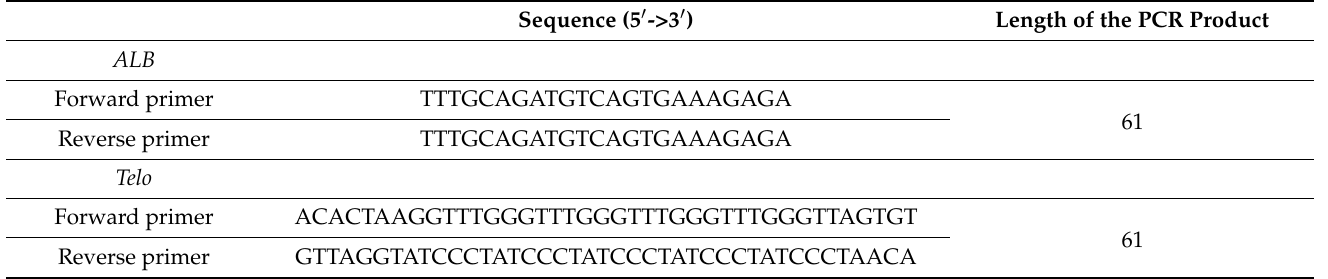
Table 2. Primers’ sequences and expected length of synthesis product.